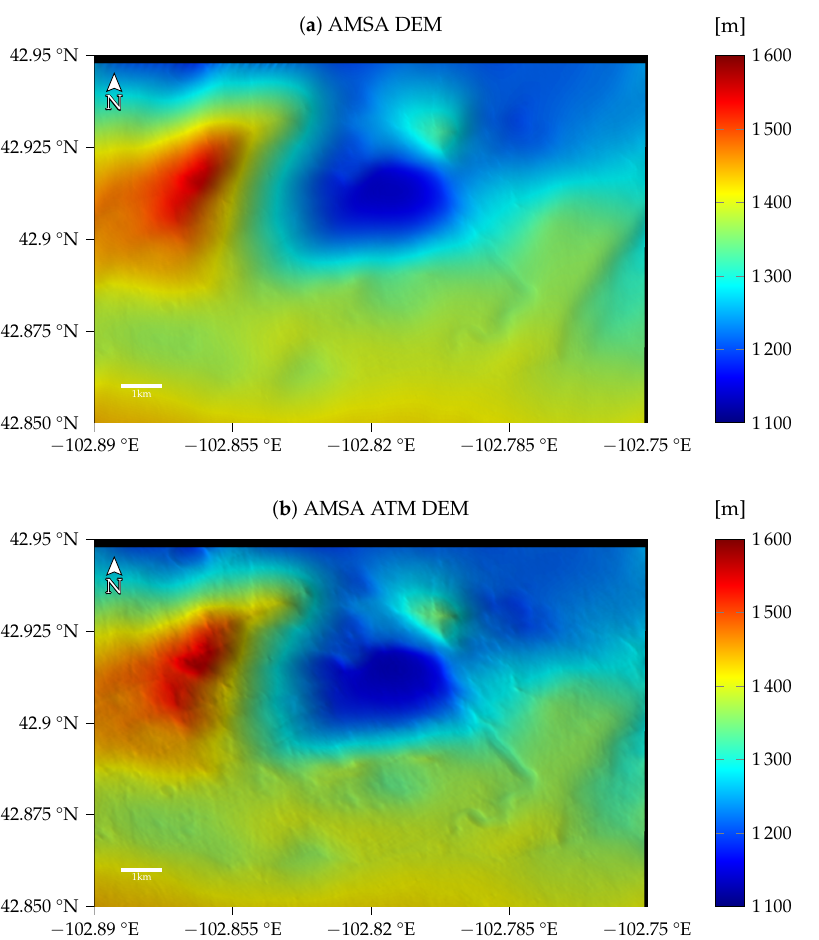
Figure 11. Results for image K13_058554_2232_XN_43N103W ( a ) without and ( b ) with atmospheric compensation. The results for γ = 3 10 − 3 and, in the case of the SfS with atmospheric compensation, × τ = 0.61 are shown. Table 6. Comparison of the Root Mean Square Errors (RMSEs) for the examined lines in the